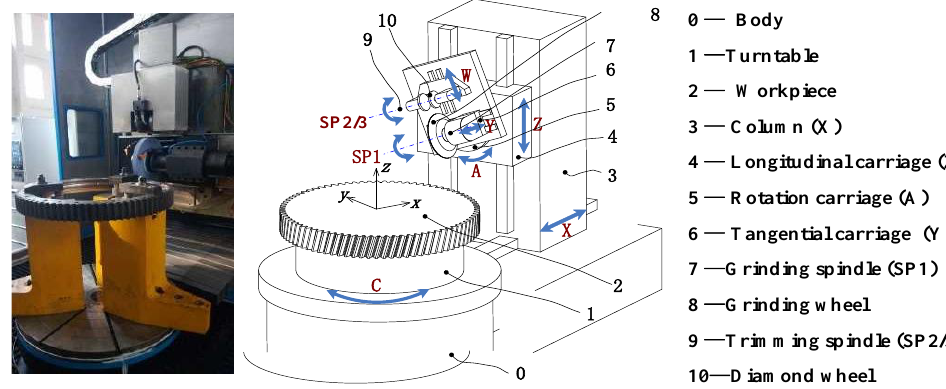
Figure 1. Schematic of a large-scale CNC gear profile grinding machine.